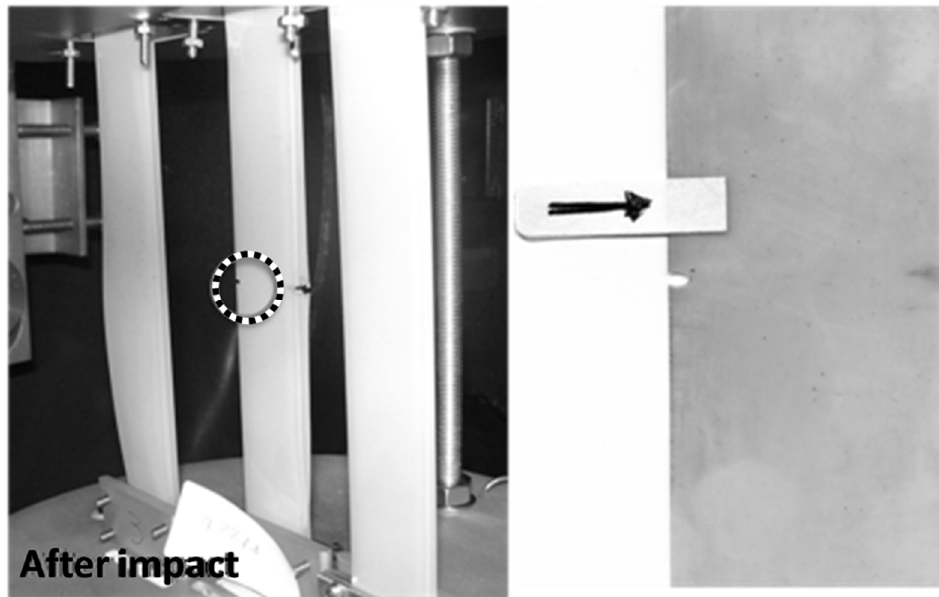
Figure 2. Setup for tape tether impact tests ( left ) and impact damage due to a tape tether ( right , impact direction parallel to the tether face).